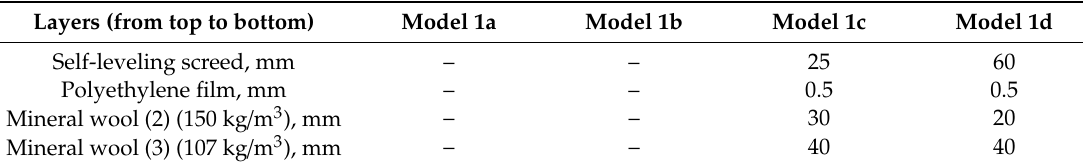
Table 1. Specification of the wood frame floors (models